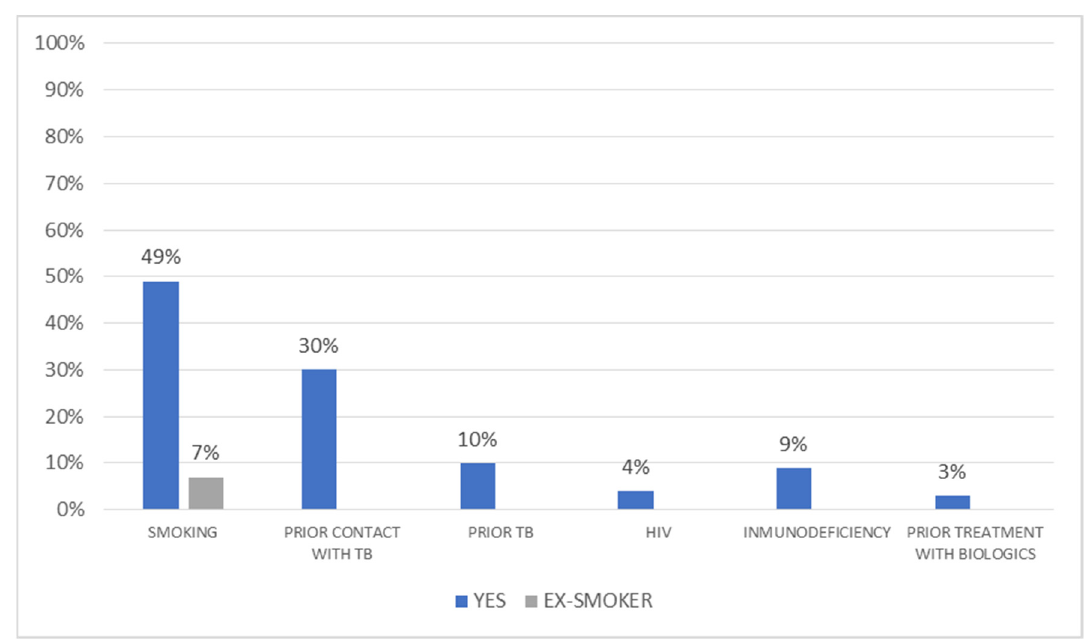
Figure 1. Risk factors for tuberculosis in the study population. TB: Tuberculosis. Of all TPE patients, 46 (65%) were natives and 25 (35%) were immigrants: 10 from Latin America, 6 from Morocco, 3 from Senegal, 2 each from Argelia and Eastern Europe, and 1 each from Pakistan and Mauritania. Figure 2 shows the proportion of native and immigrant patients in 5 year periods.